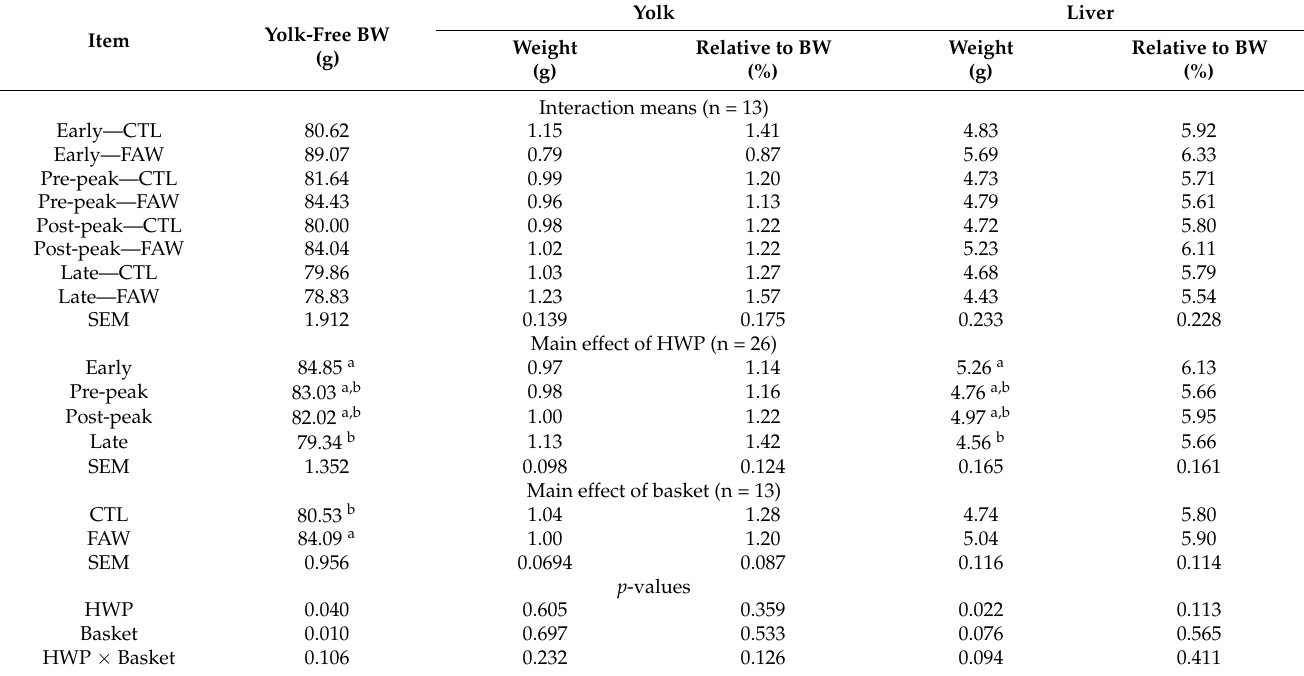
Table 3. Effects of hatch window period (HWP) and nutrient access of feed and water (FAW) or control (CTL) in the hatching basket on body, yolk, and liver weights of 3 d old broiler